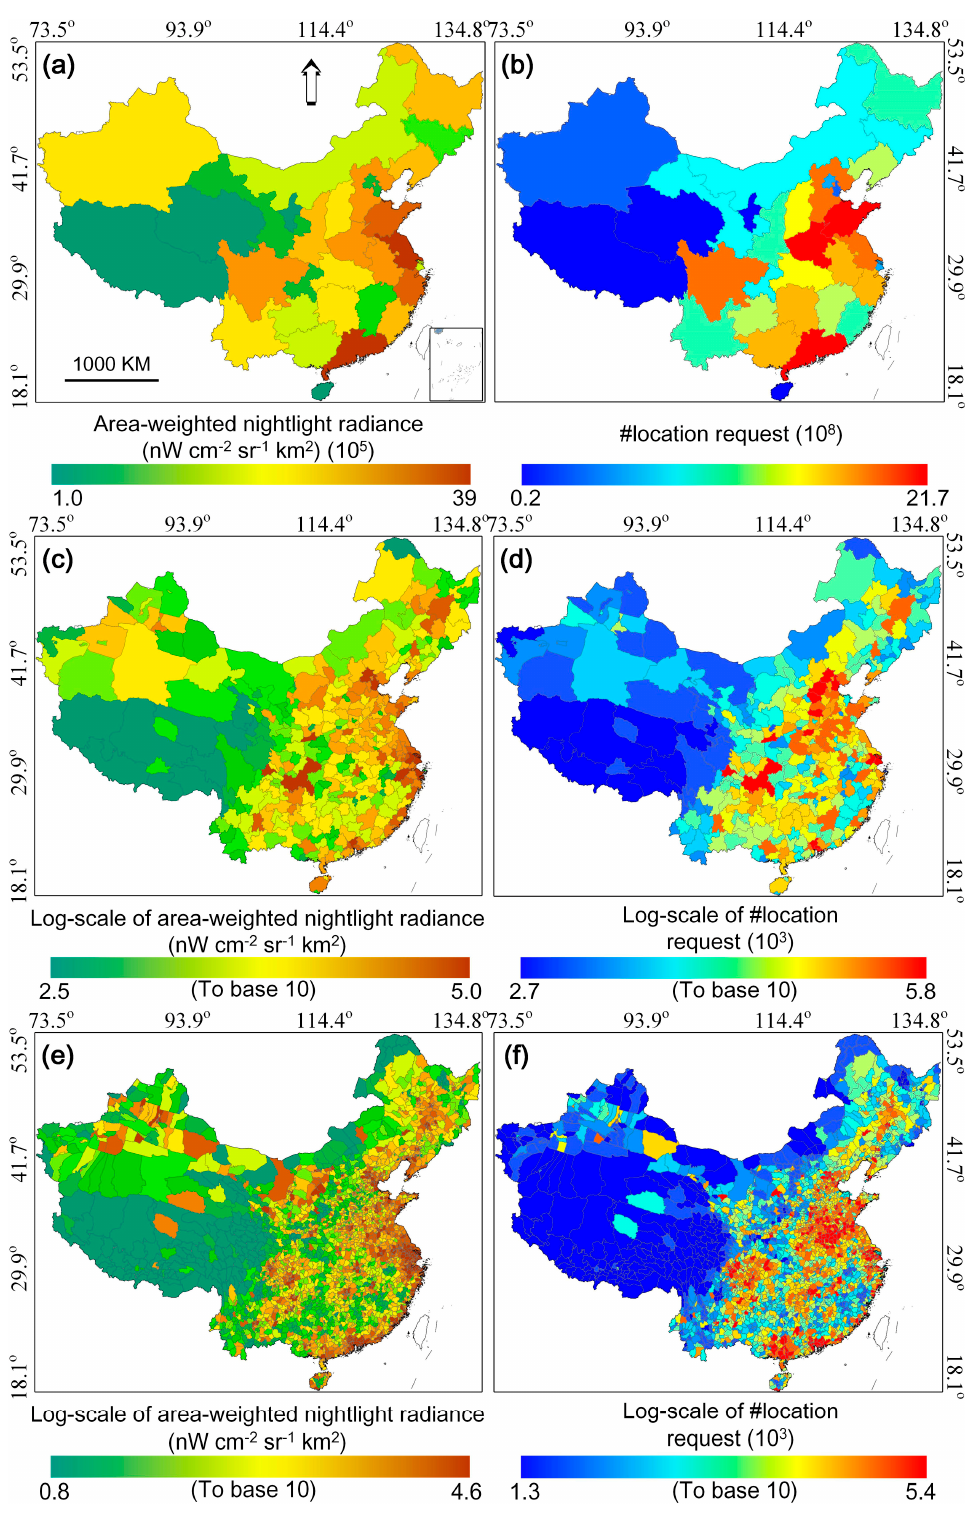
Figure 4. Spatial distributions of regional area-weighted nighttime light radiances ( left, a, c and e ) and the number of location requests ( right, b, d and f ) at the provincial ( upper, a and b ), the city ( middle, c and d ), and the county ( lower, e and f ) levels across China.